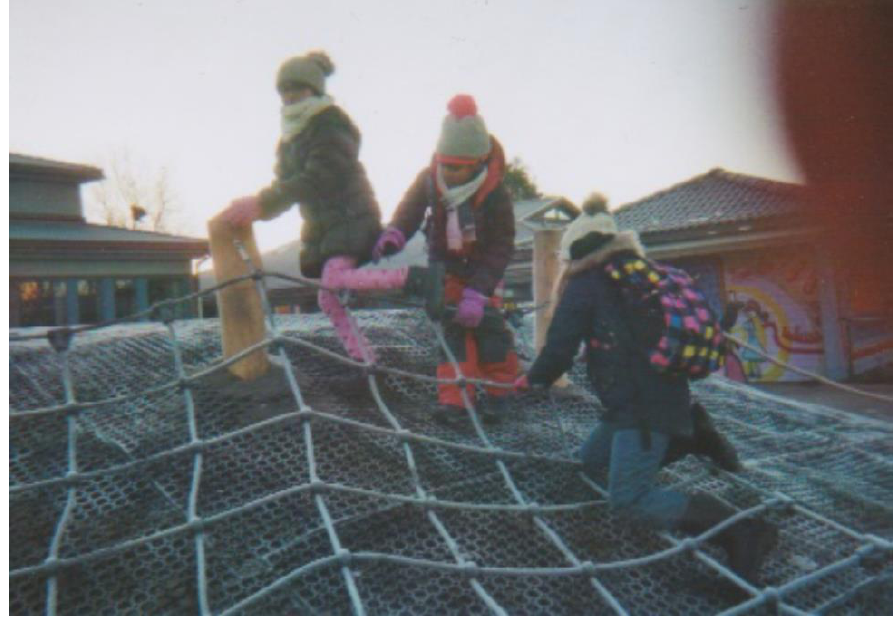
Figure 2. The Heap (photograph taken by Pupil 5).